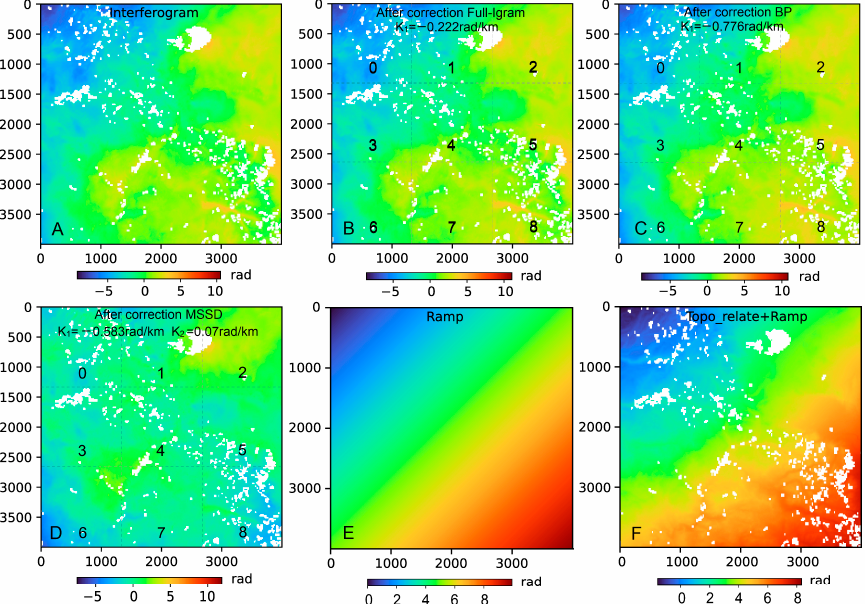
Figure 9. Comparison between the interferograms in the Sierra Nevada mountains before and after correction using the MSSD approach; ( A ) the original interferogram ( B ) the corrected interferogram obtained through the full interferogram–topography approach ( C ) the corrected interferogram obtained through the BP approach and ( D ) that obtained by MSSD; ( E , F ) the ramp component and the sum of topography-related component and ramp component, both acquired by the MSSD approach. Notice that the phase gradient in ( D ) is reduced after correction. Correlation coefficients of 9 sub-regions(0–8) are shown in Table 2.